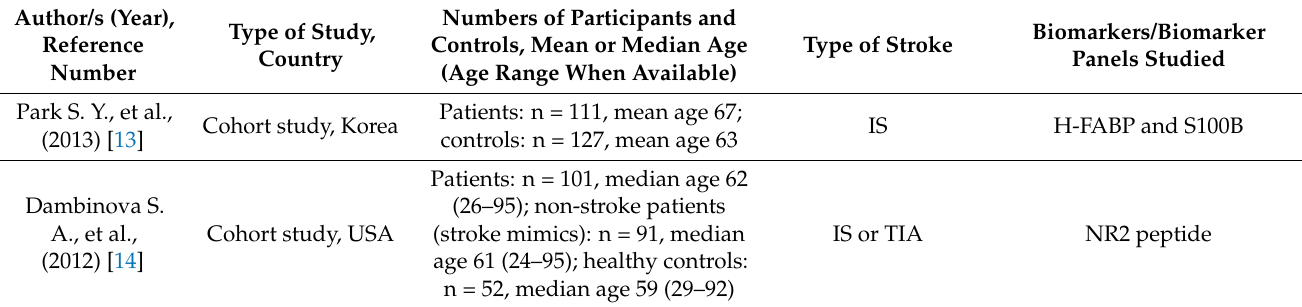
Table 1. Included studies in this literature